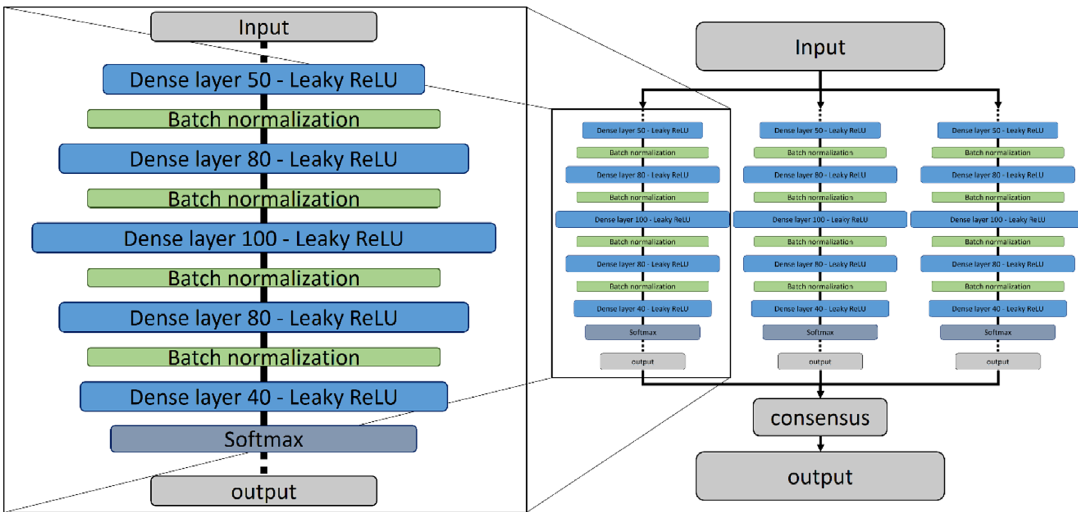
Fig. 2. Left panel: the architecture of the NNs showing the layers and numbers of neurons. Right panel: the structure which combines the outputs of the individual